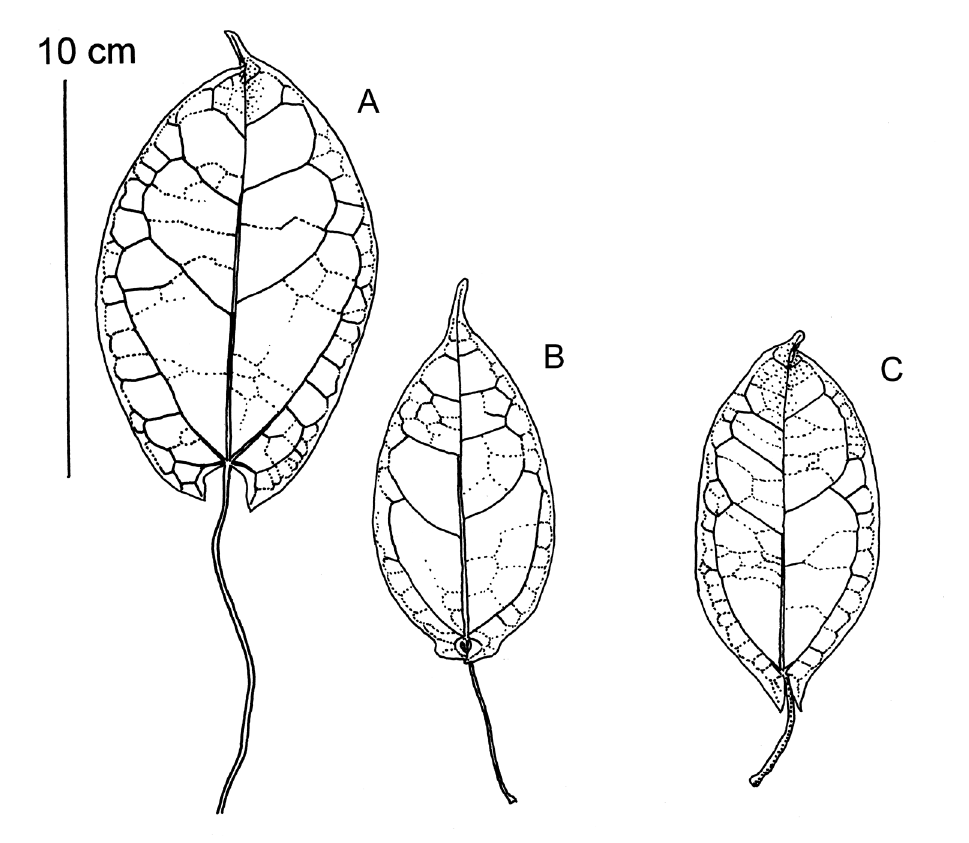
Figure 3 – Kolobopetalum auriculatum leaf shapes showing variation in leaf bases. A from J.J. de Wilde & van der Maesen 11007 (WAG); B from Carvalho 5119 (WAG); C from Reitsma c.s. 1337 (WAG). Drawn by Hans de